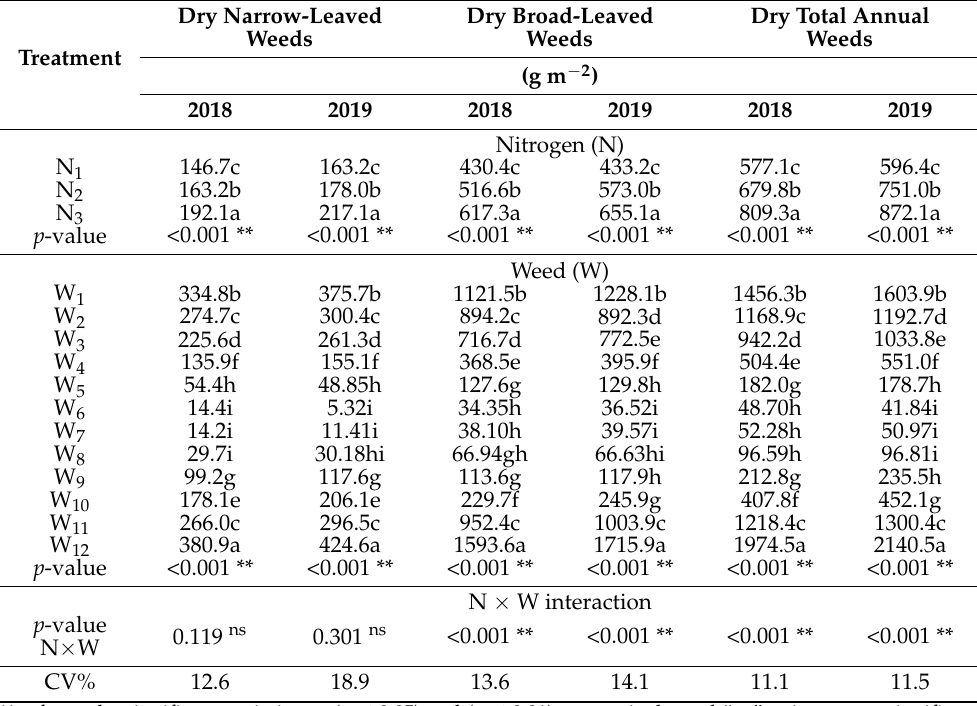
Table 4. Effect of nitrogen fertilization levels (N) and time (early and late) weed removal (W) on dry weight of narrow-leaved, broad-leaved, and total annual weeds that accompaniment to peanut ( Arachis hypogaea L.) in 2018 and 2019